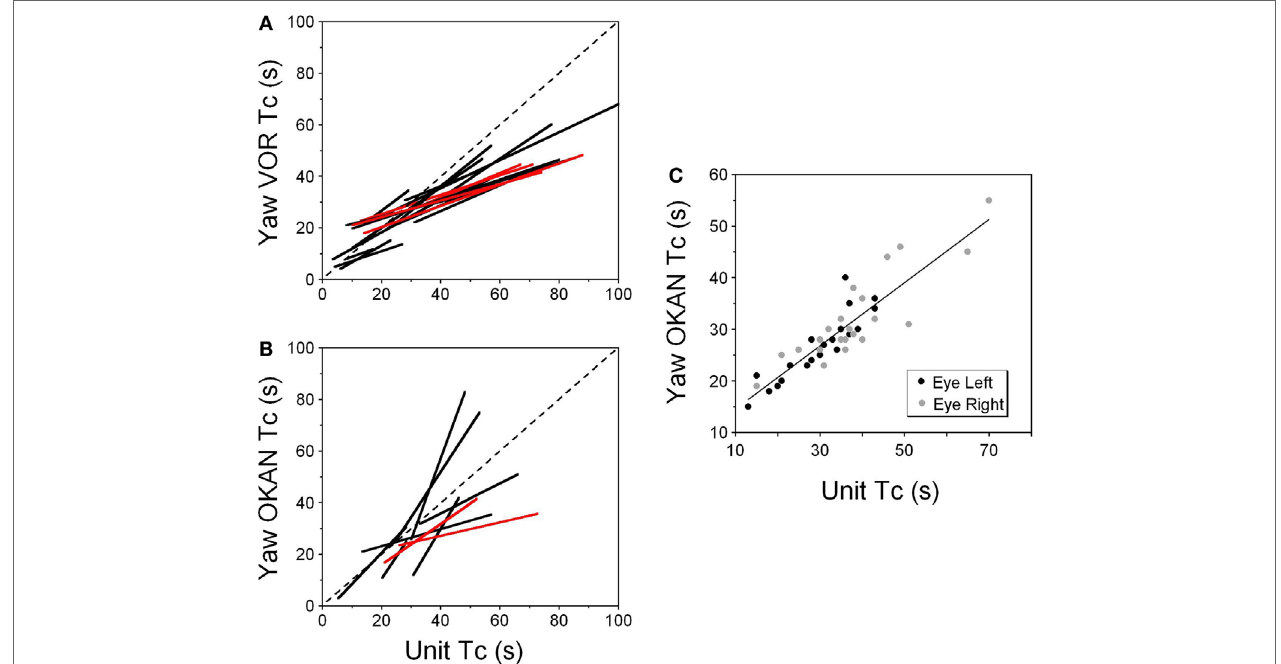
FigUre 8 | (a,B) Relationship of the time constant of velocity storage measured from the yaw slow phase eye velocity (abscissa) during vestibular nystagmus (a) and optokinetic after-nystagmus (OKAN) (B) and measured from the changes in the neuronal firing rate (ordinate). The individual lines are regression lines for the vestibular-only (black) and VPS (red) neurons. (c) Relationship between the time constant of the yaw component of velocity storage tested with 60°/s optokinetic nystagmus/OKAN while the head was tilted side down at various degrees up to 90°. The time constant of the decline in neuronal firing is shown in Figure 9